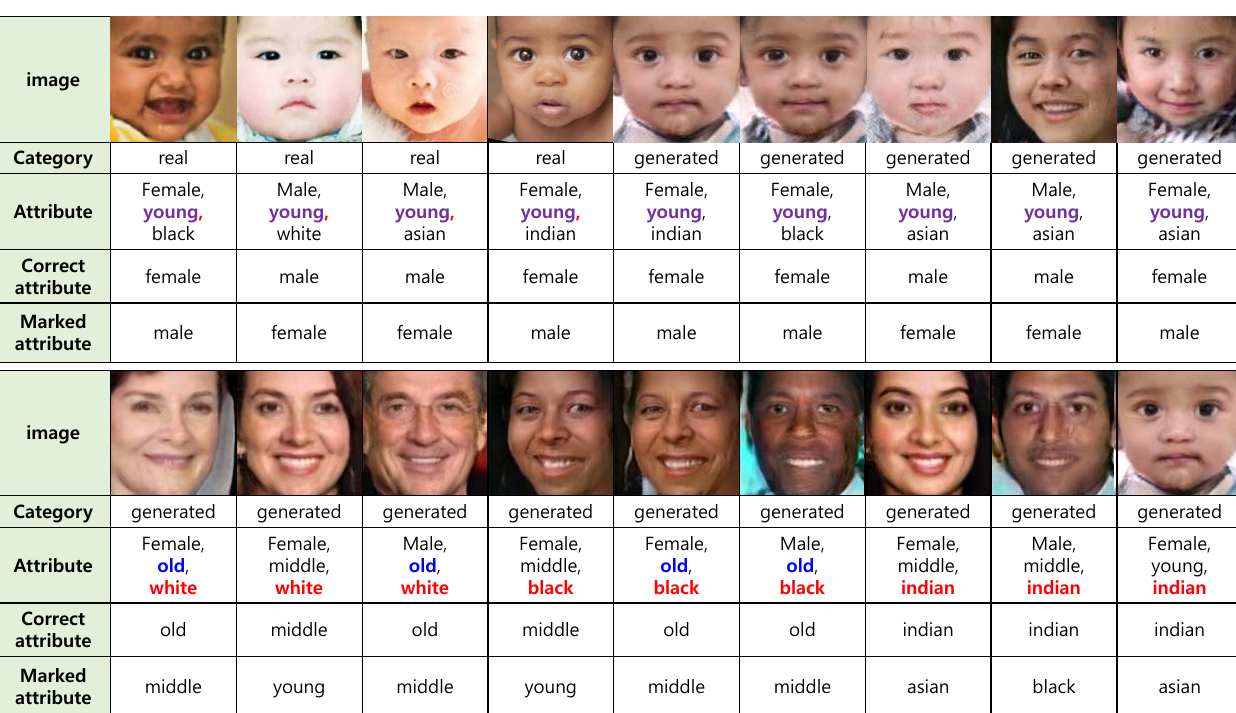
Figure 8. Comparison of the user study. Three rows represent sex, age, and race, and three columns represent sex, age, and race scores, respectively. The generated images recorded four relatively lower scores than those of real images, which are marked as blue and red rectangles. Another notable indication was the sex score for young, which is marked as a violet rectangle. This score was the worst in both real and generated images.